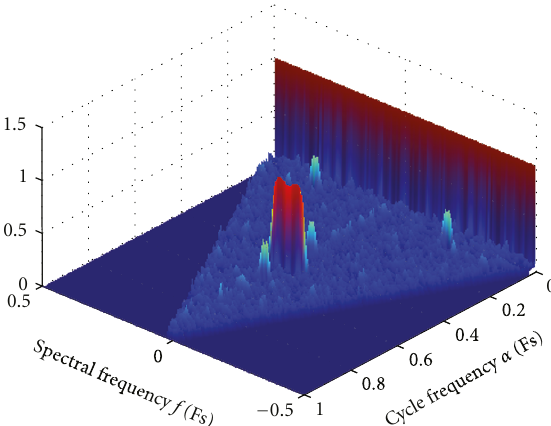
Figure 3: SOF of a BPSK signal in a Multipath Fading Channel at 5dB SNR, with 1/Ts = Fs/10, Fc = 0.25 Fs, no. of samples = 4096.